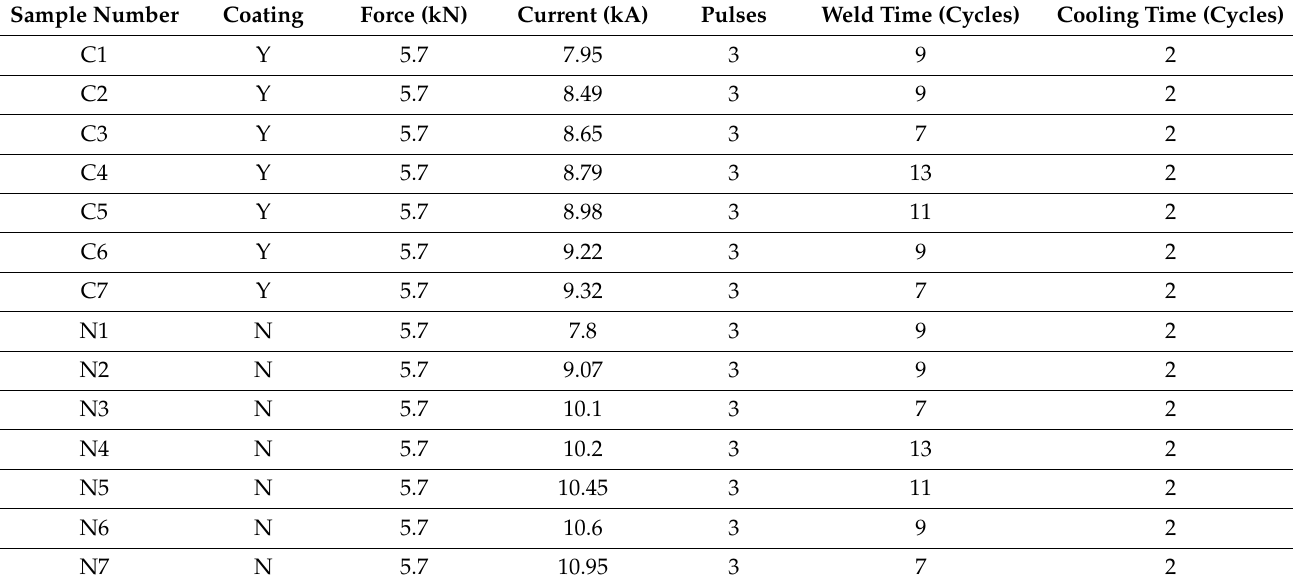
Table 2. Welding parameters for static tensile shear samples.